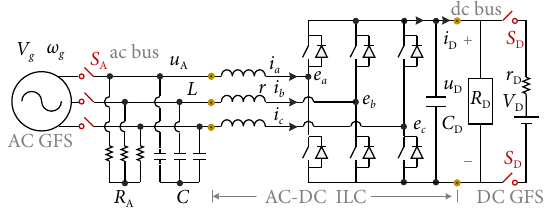
Fig. 5 A detailed configuration of a hybrid microgrid.